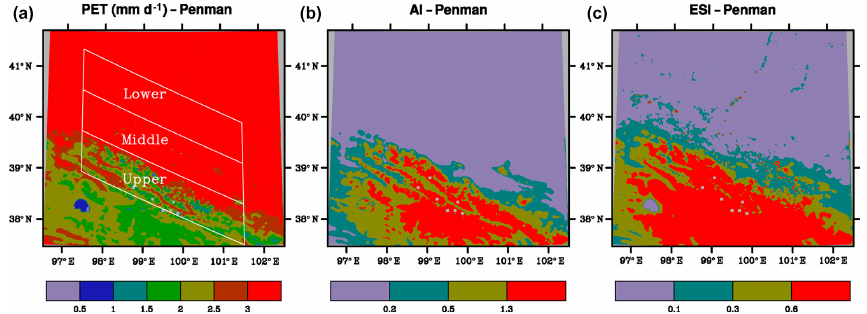
Figure 6. Spatial distributions of potential evaporation (PET, mmd − 1 ), aridity index (AI) and evaporative stress index (ESI) with PET estimated using the Penman–Monteith method. Averaged over 1980–2010. The Heihe River basins are shown in panel (a) . The color bars from left to right for AI and ESI are arid, semiarid, semihumid and humid